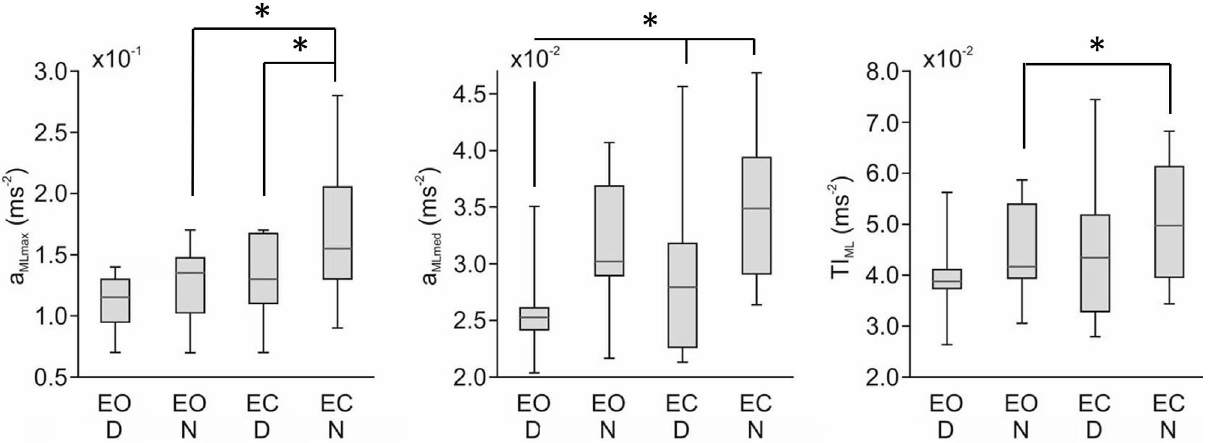
Figure 5. Comparison of maximum (max) and median (med) medio-lateral accelerations and tremor intensity (TI) of medio-lateral acceleration of dominant (D) and non-dominant (N) upper arms of subjects standing with eyes open (EO) and eyes closed (EC). *statistically significant